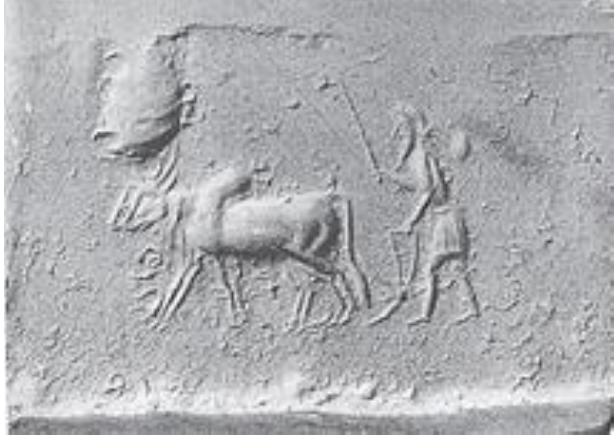
Figure 22. Ploughing scene on Achaemenid seal